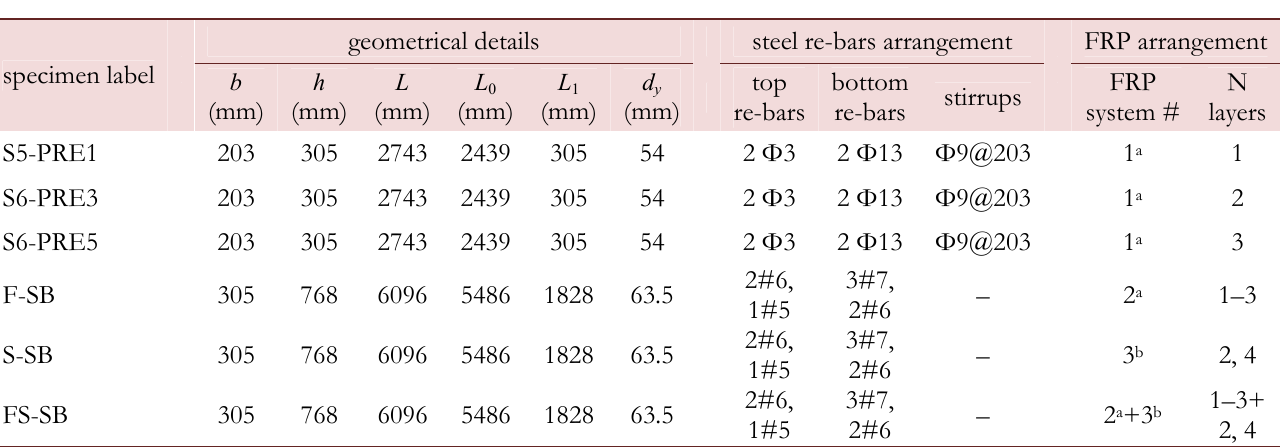
Table 4: Geometrical and mechanical details of the analysed specimens